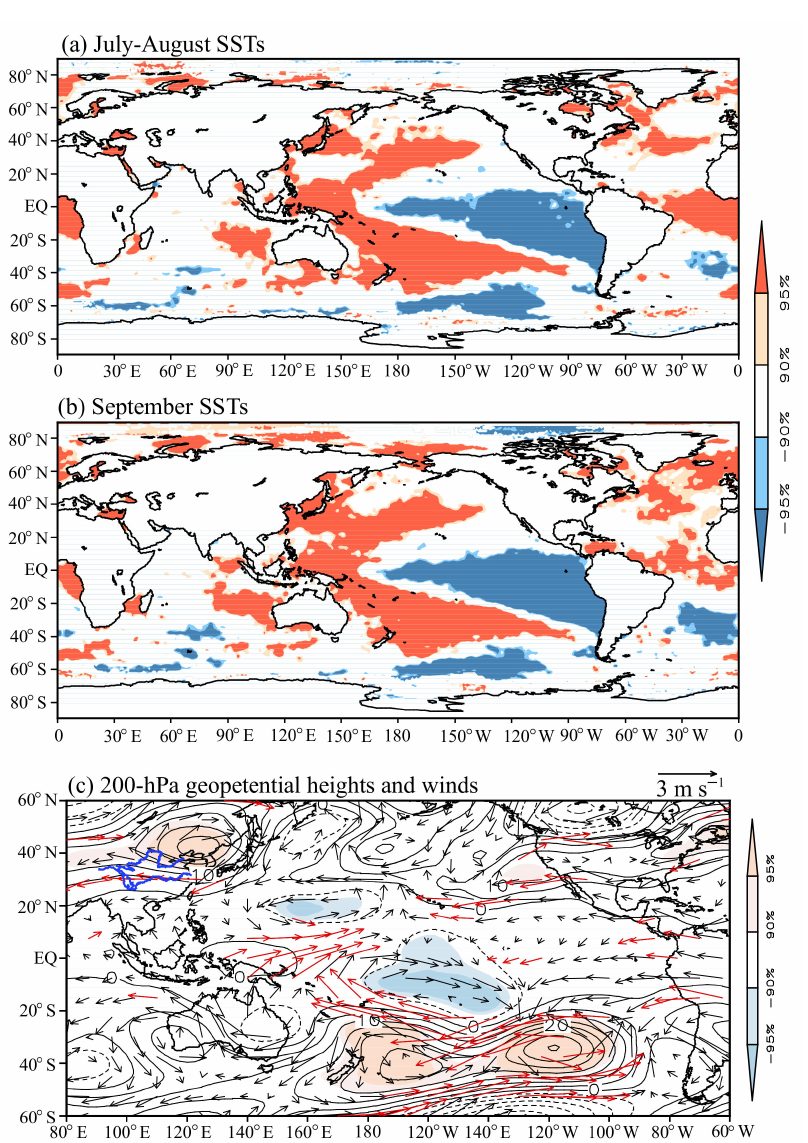
Figure 8. Distribution of correlation coefficients between the July–August individual SPSP index and (a) simultaneous and (b) September SSTs during the period 1979–2021. Shadings in ( a , b ) denote the correlation significant at the 90 and 95% confidence levels; ( c ) Anomalies of September 200 hPa geopotential heights (contours; units: gpm) and winds (vectors; units: m s − 1 ) obtained by regressing upon the July–August individual SPSP index. Shadings in ( c ) represent anomalies in geopotential heights significant at the 90 and 95% confidence levels. Red vectors denote anomalous winds significant at the 95% confidence